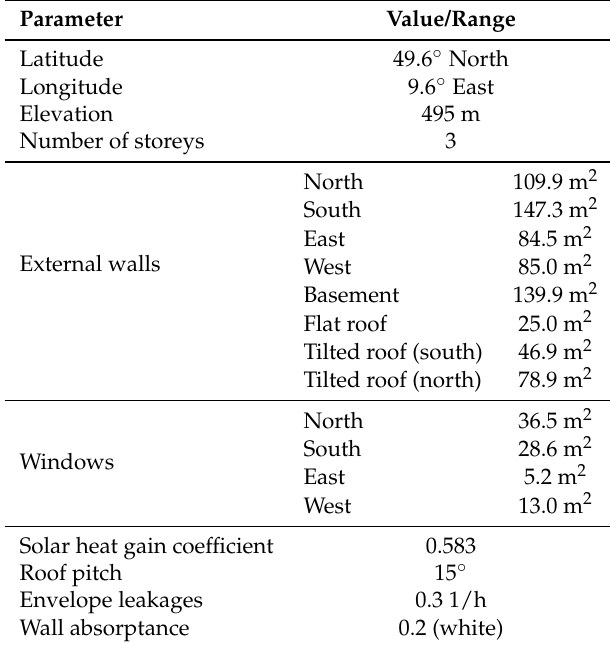
Table 1. Building geometry.